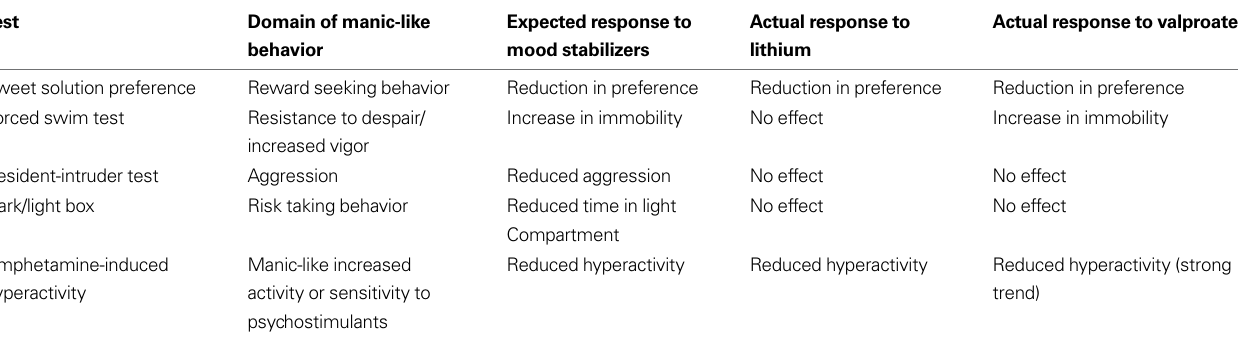
Table 3 | The domains of ‘manic-like’ behavior modeled in the battery, the expected response and actual response to mood stabilizers in BS mice.